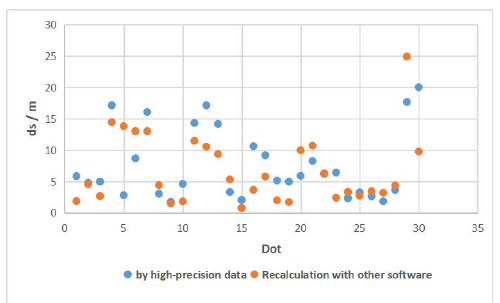
Figure 5. Errors of plane accuracy in field 2